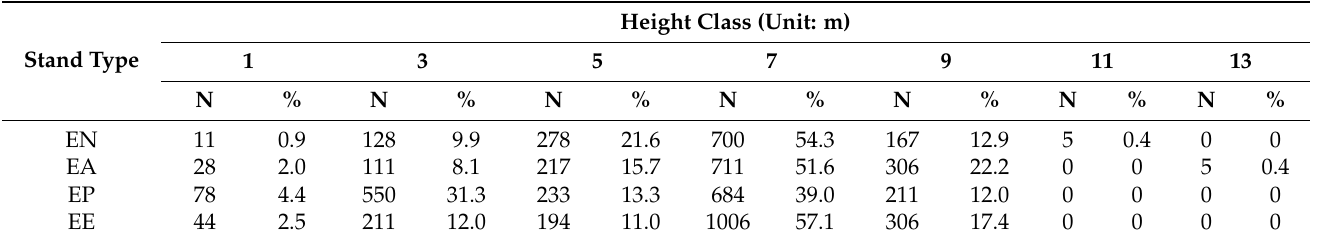
Table 4. Tree height distribution of pure Eucalyptus forest and mixed- Eucalyptus forest.